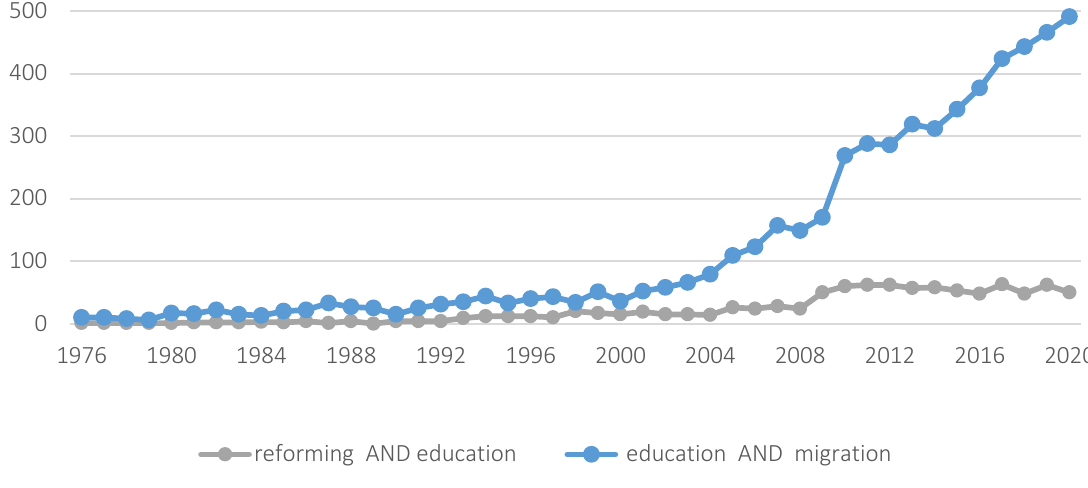
Figure 1. Dynamics of publications in the field, according to the search with different combinations of the keywords, “reforming” and “education”, “education” and “migration”,